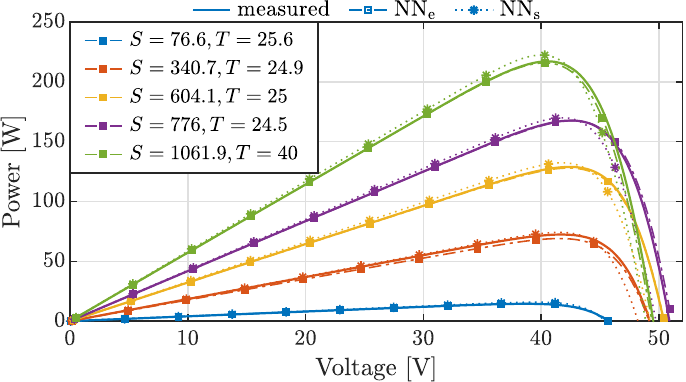
Figure 11. Comparison between measured P - V curves and P - V curves generated by NN